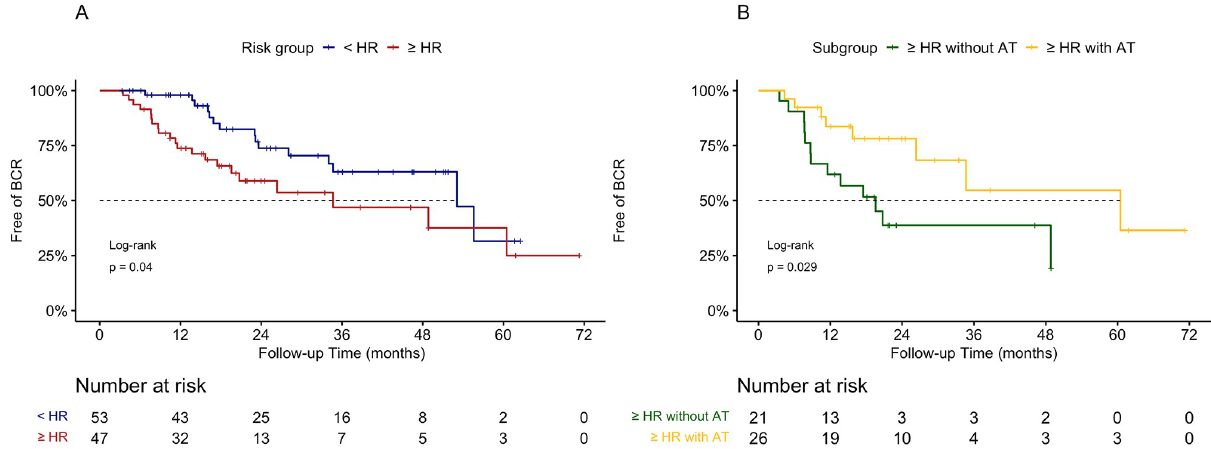
Fig 1. A: Biochemical recurrence (BCR)-free survival among prostate cancer patients in the below high-risk group ( < HR) and the high-risk/very high- risk group ( � HR). B: BCR-free survival among patients in the high-risk/very high-risk group, without adjuvant treatment ( � HR without AT), and high- risk/very high-risk group, with adjuvant treatment ( � HR with AT).